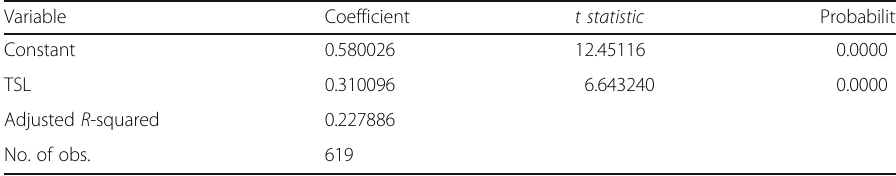
Table 21 How TFP is affected by TSL — ROECD Variable Coefficient